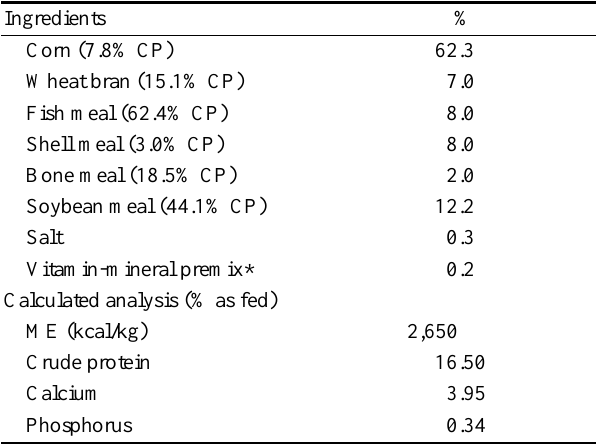
Table 1. Ingredient composition and nutrient analyses of the basal diet (%) Ingredients